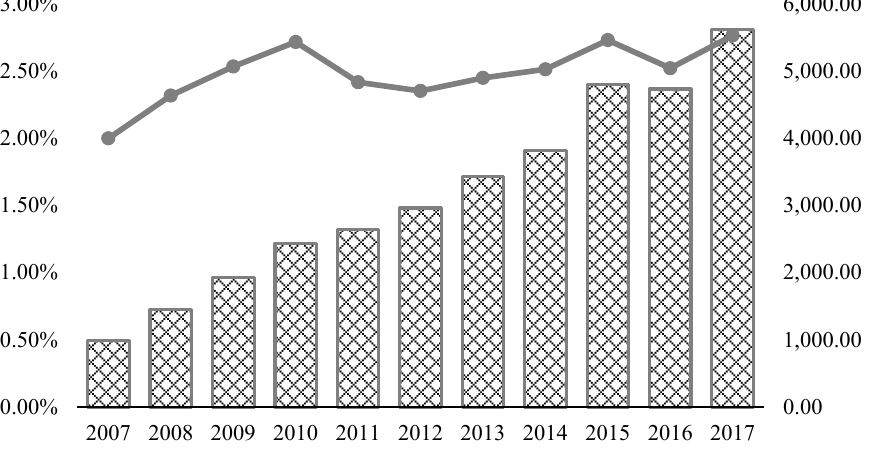
Figure 1. Environmental protection investment in China during 2007–2017.